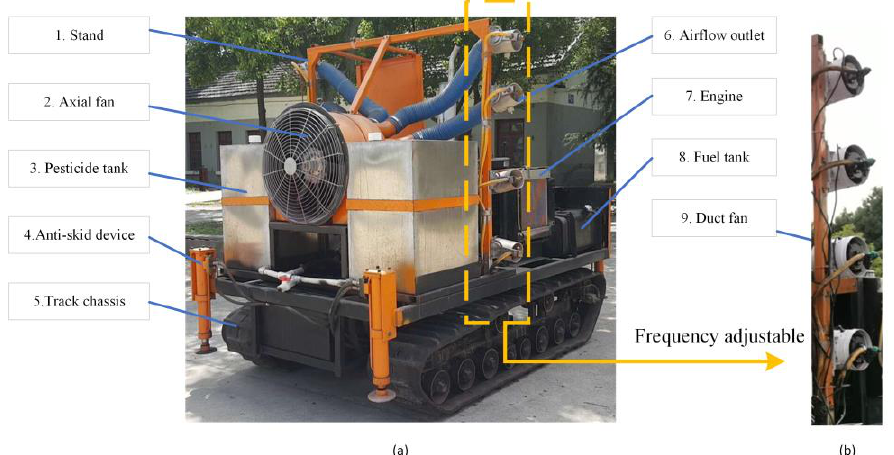
Figure 2. Crawler-type multi-channel orchard air-assisted sprayer. (a) Structure display of Crawler-type multi-channel orchard air-assisted sprayer. (b) Layout of four duct fans.